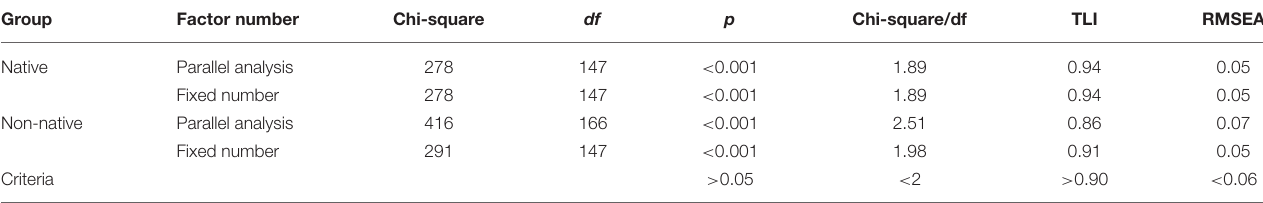
TABLE 2 | Observed fit statistics values and criteria for adequacy based on exploratory factor analysis (EFA).